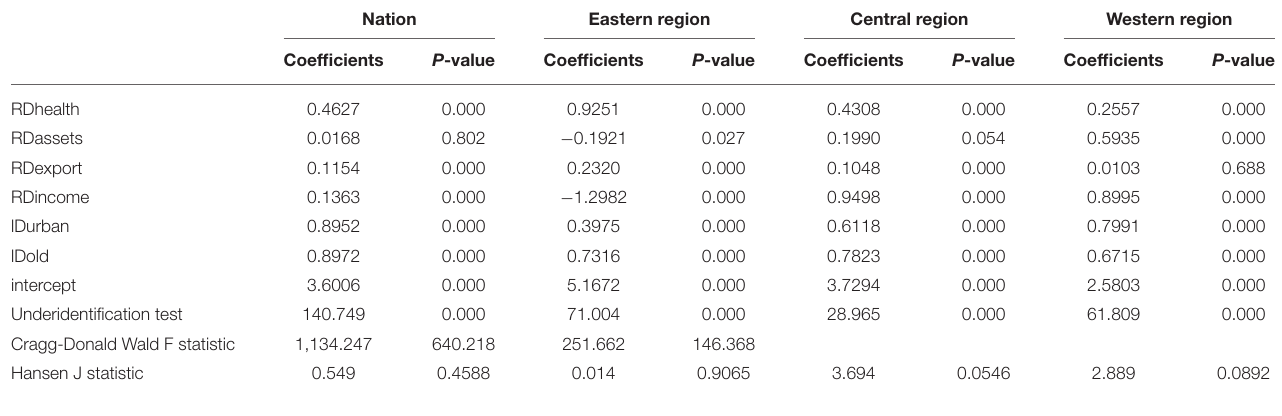
TABLE 7 | Endogenous test